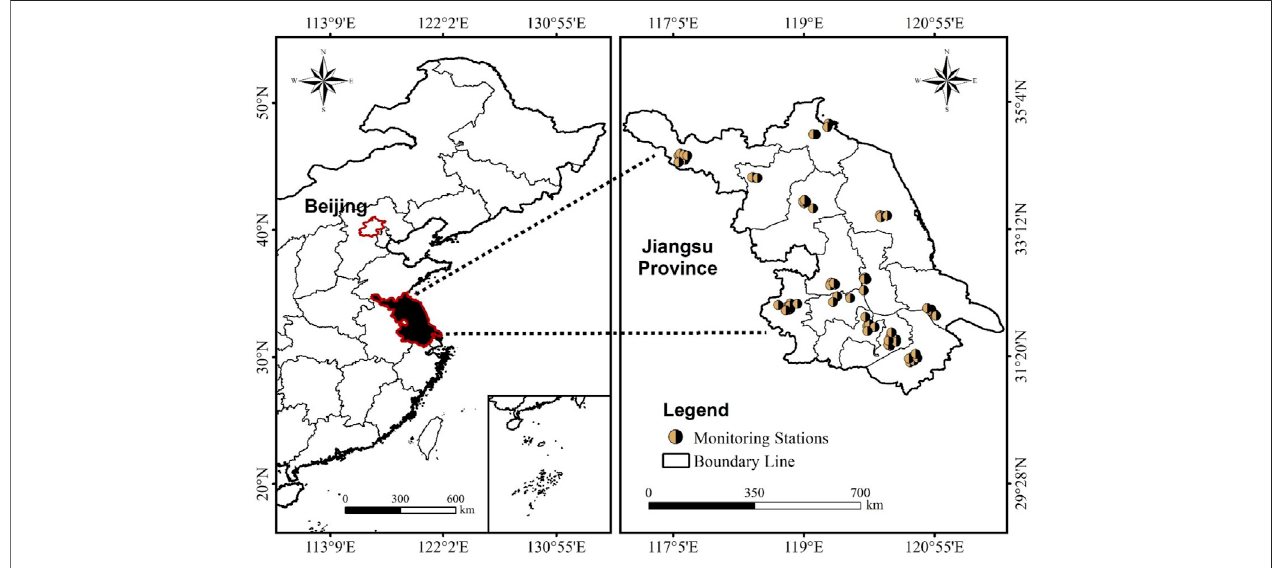
FIGURE 1 | Location of the study area and distribution of monitoring stations in Jiangsu